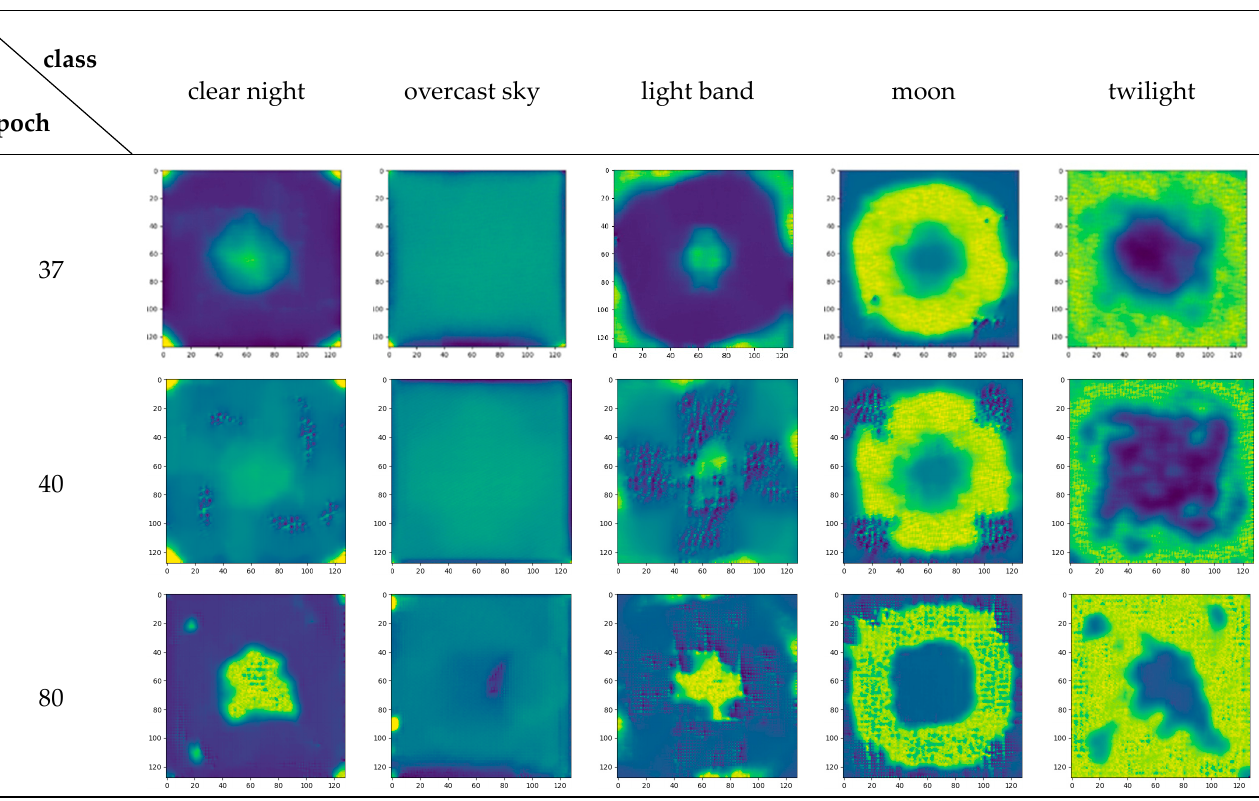
Figure 7. Feature maps of di ff erent epochs.